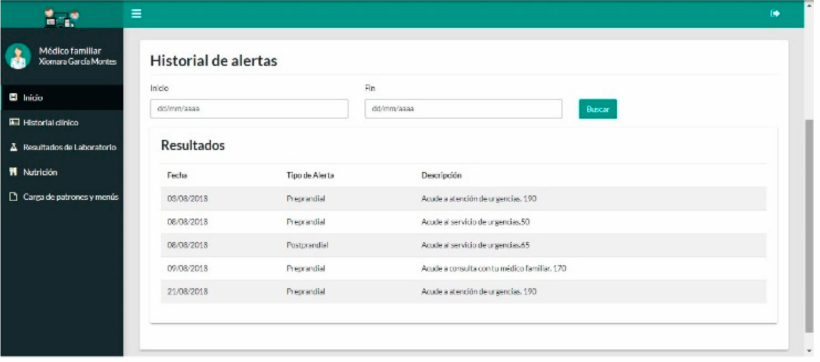
Figure 21. Physician application interface: Report of alerts generated by the